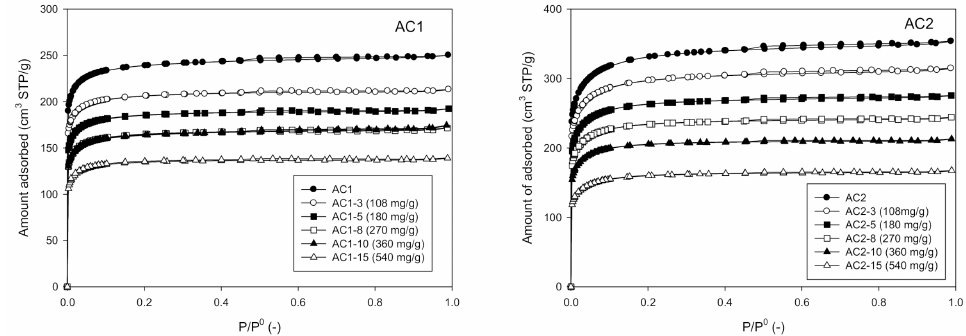
Figure 1. Effect of NaOH impregnation loading on N2 adsorption isotherms measured at 77 K for AC1 and AC2 original activated